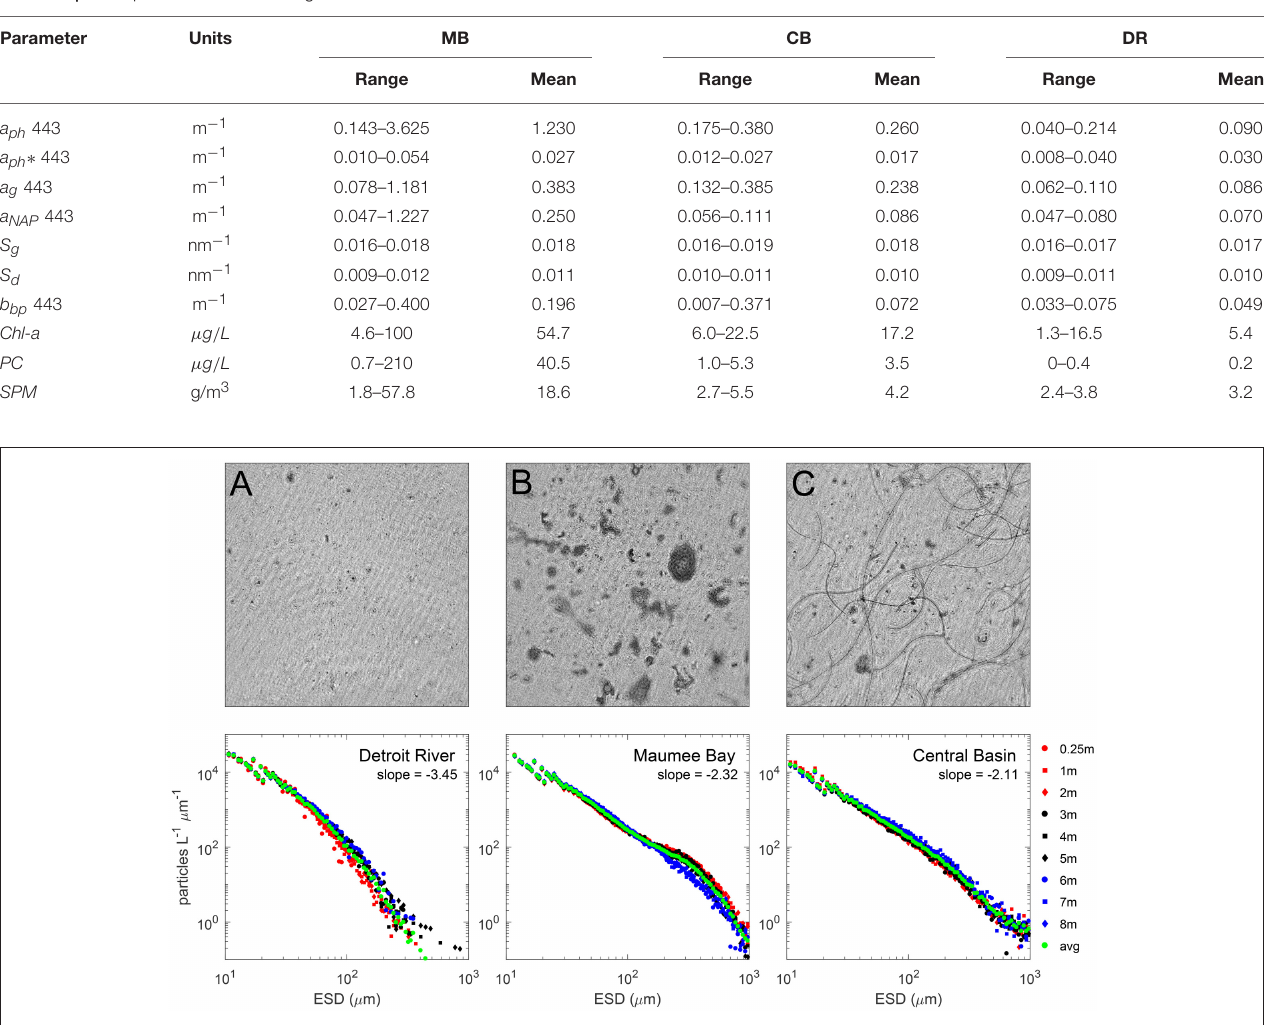
TABLE 1 | Water parameters for three regions in the western basin. Parameter Units